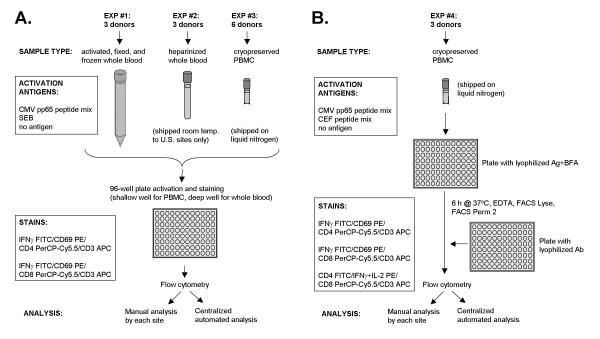
Experimental design. (A) Schematic of protocol for Experiments 1–3, performed using liquid antigens and antibodies. (B) Schematic of protocol for Experiment 4, performed using lyophilised antigen and antibody plates.